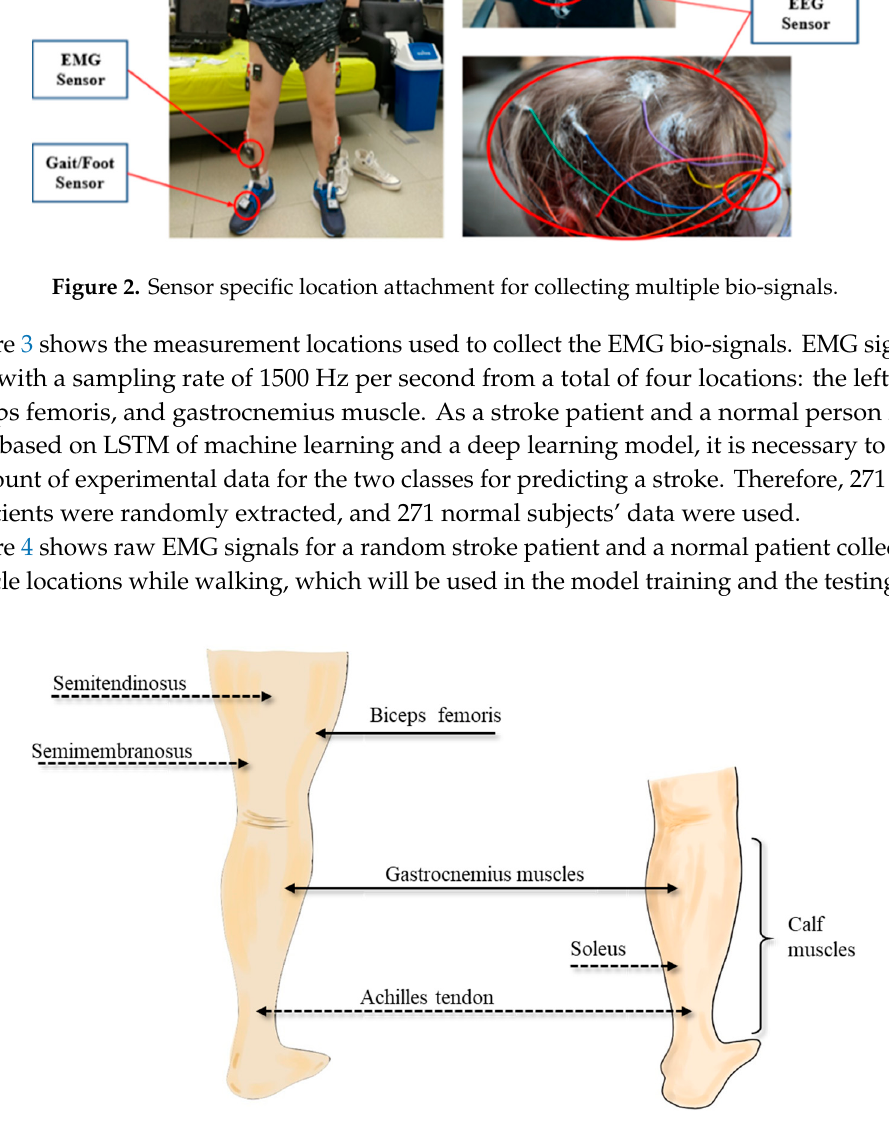
Figure 3. Real-time measurement location for EMG bio-signal (Left image: biceps femoris, right image: gastrocnemius muscle).